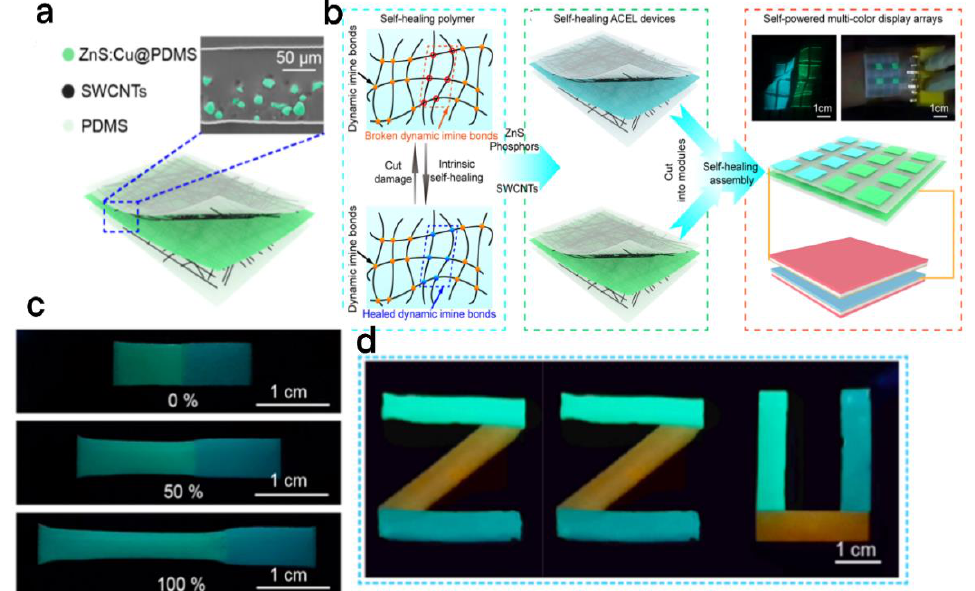
Figure 11. ( a ) Schematic representation of the stretchable self-healing ACEL device consisting of two electrodes and an emissive layer. ( b ) The working mechanism of the self-healing polymer and the manufacturing route of the ACEL self-powered red multicolor display. ( c ) Photographs of the healed emissive layer at different loads (0%, 50%, and 100%). ( d ) Multicolor display with a ZZU [81]. Chang et al. (2022), Elsevier.